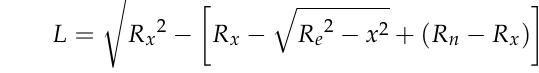
where R e is the radius of the equivalent cylinder.